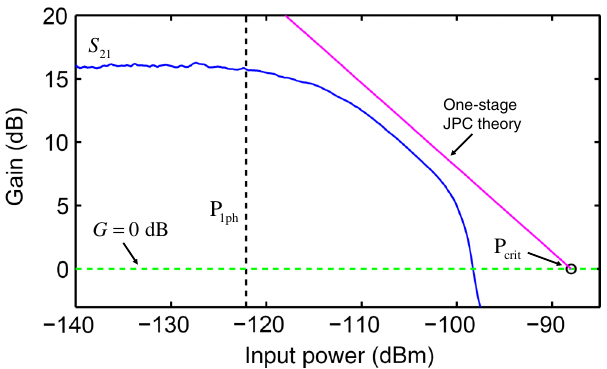
FIG. 5. A measurement of the maximum input power of the device obtained at the desired working point, indicated by a vertical dashed line in Fig. 2(a). The power gain S 21 , drawn in blue, is measured as a function of the input signal power. The vertical dashed black line indicates the input power of one photon at the signal frequency per inverse dynamical bandwidth at G ¼ 16 dB . The solid magenta line is the expected upper limit on the maximum input power of a one-stage JPC, caused by the pump-depletion effect